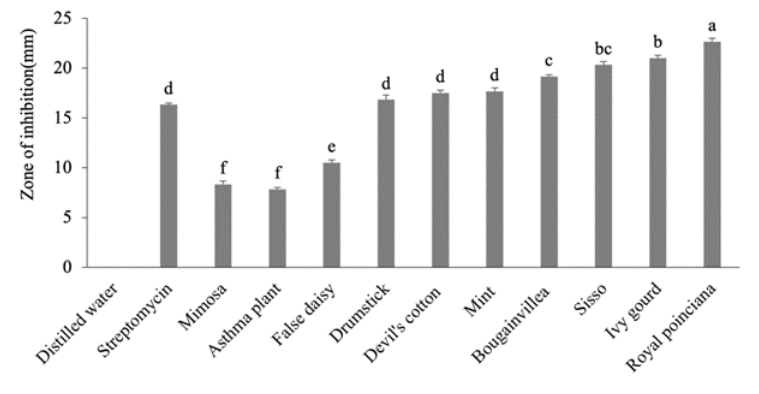
Figure 2 Antibacterial effect of 50% aqueous extracts of medicinal plants. e letters represent the significant effects of plants on each other. e whiskers above the bars represent standard error ( SE ).